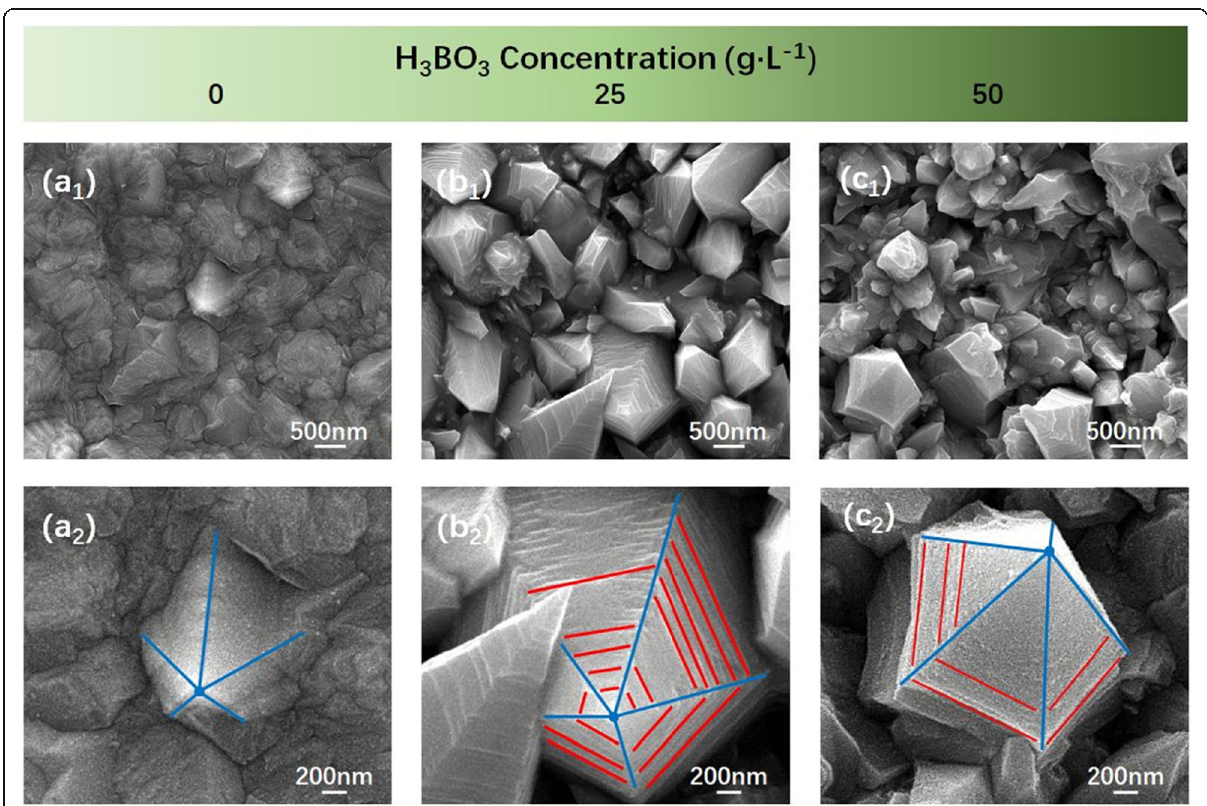
Fig. 6 Low- and high-magnification SEM images of cathode that electrodeposited at different H 3 BO 3 concentrations: 0 g/L ( a 1 , a 2 ), 25 g/L ( b 1 , b 2 ), and 50 g/L ( c 1 , c 2 ),